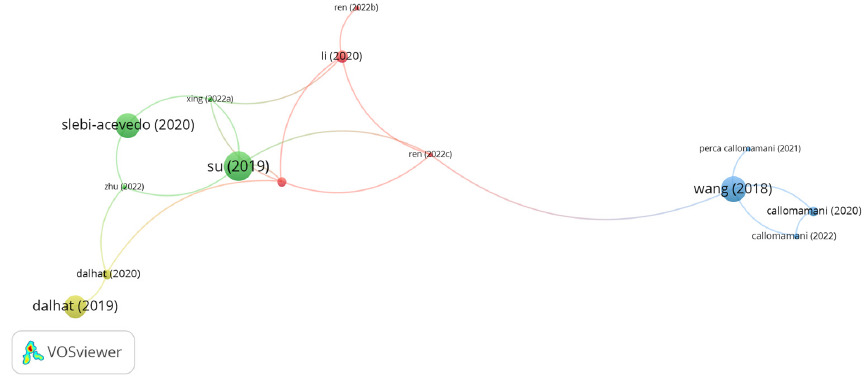
Figure 9. Network visualization of PAN fibers.